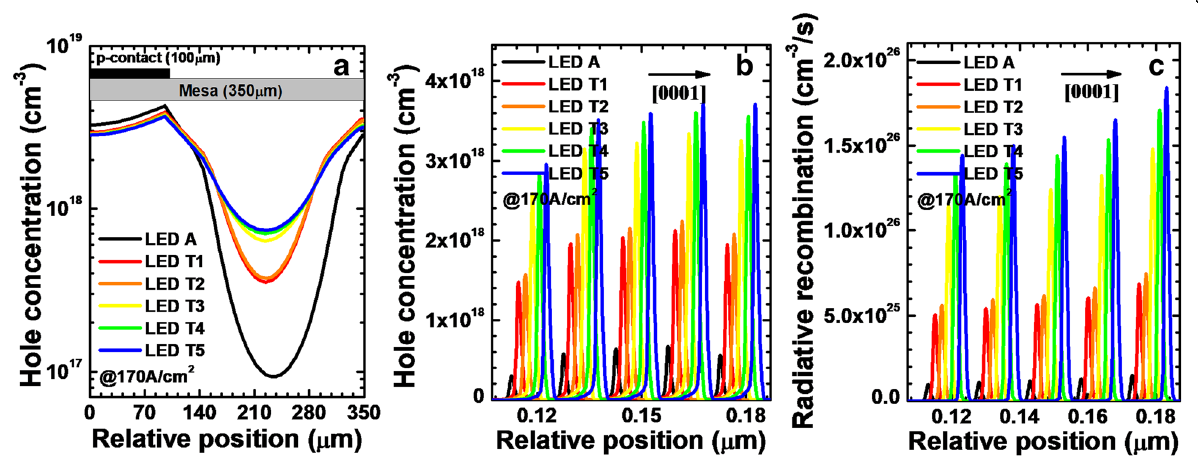
Fig. 12 a Horizontal hole concentration in the LQW, b hole concentration levels, and c radiative recombination profiles in the MQWs for LEDs A and T i ( i = 1, 2, 3, 4, and 5) when the current density is 170 A/cm 2 . We purposely shift the curves for b and c by 2 nm for easier identification